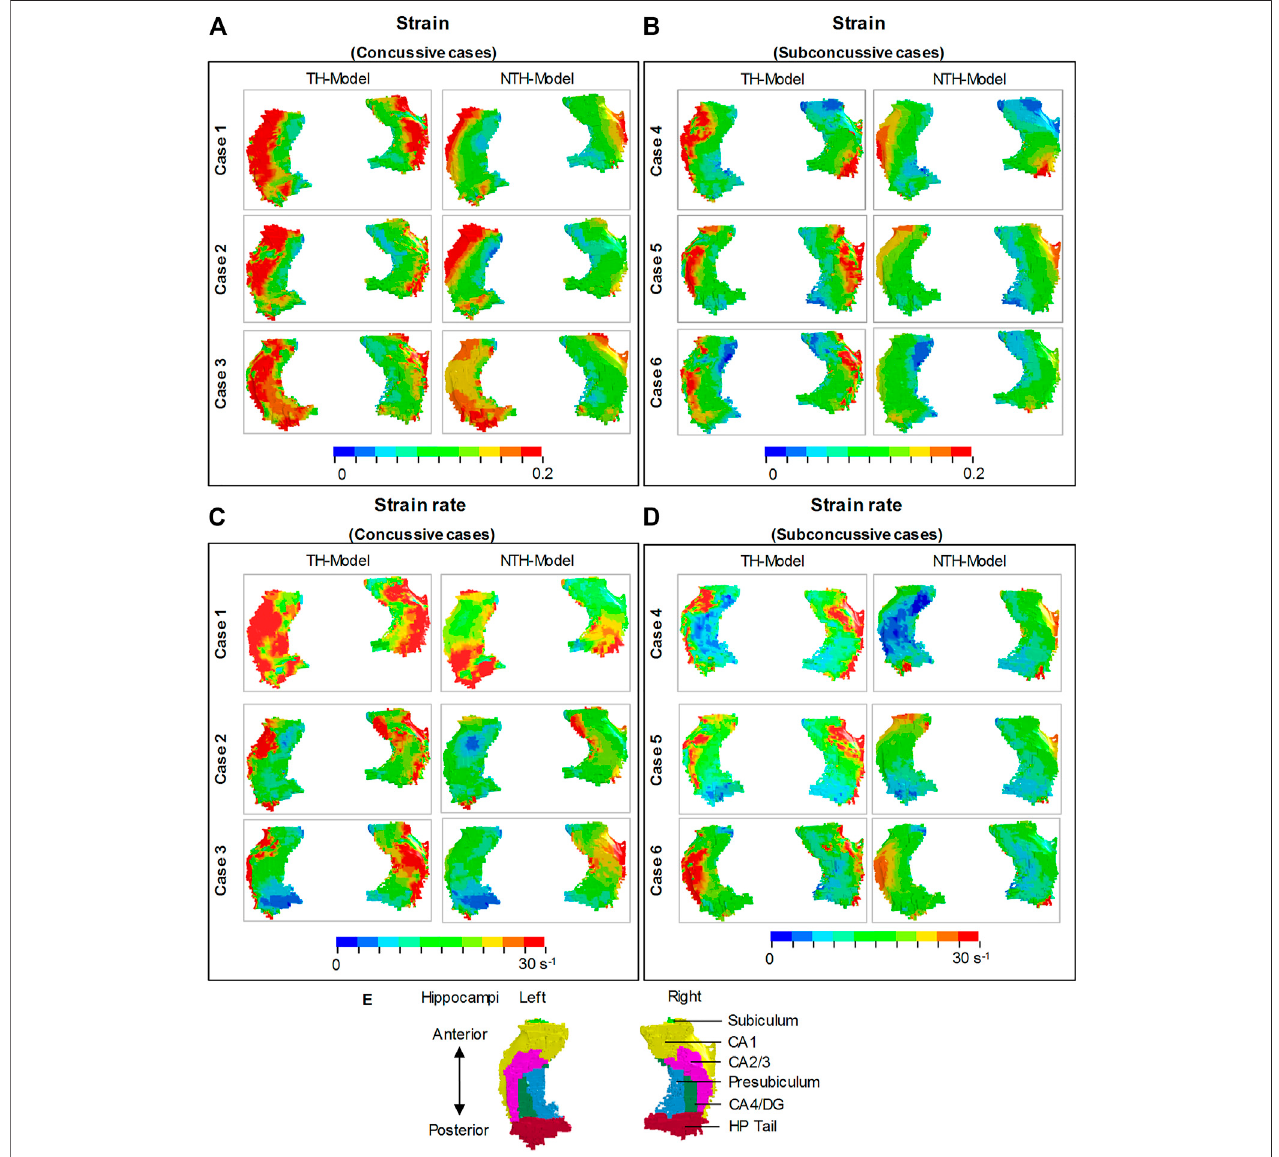
FIGURE4| Comparisonofstraindistribution (A,B) andstrainratedistribution (C,D) inthehippocampibetweentheTH-modelandNTH-modelofthreeconcussive impacts (Cases 1 – 3) and three sub-concussive impacts (Cases 4 – 6). Sub fi gure (E) illustrates the hippocampal sub fi elds. CA: cornu ammonis; DG: dentate gyrus; HP Tail: hippocampal